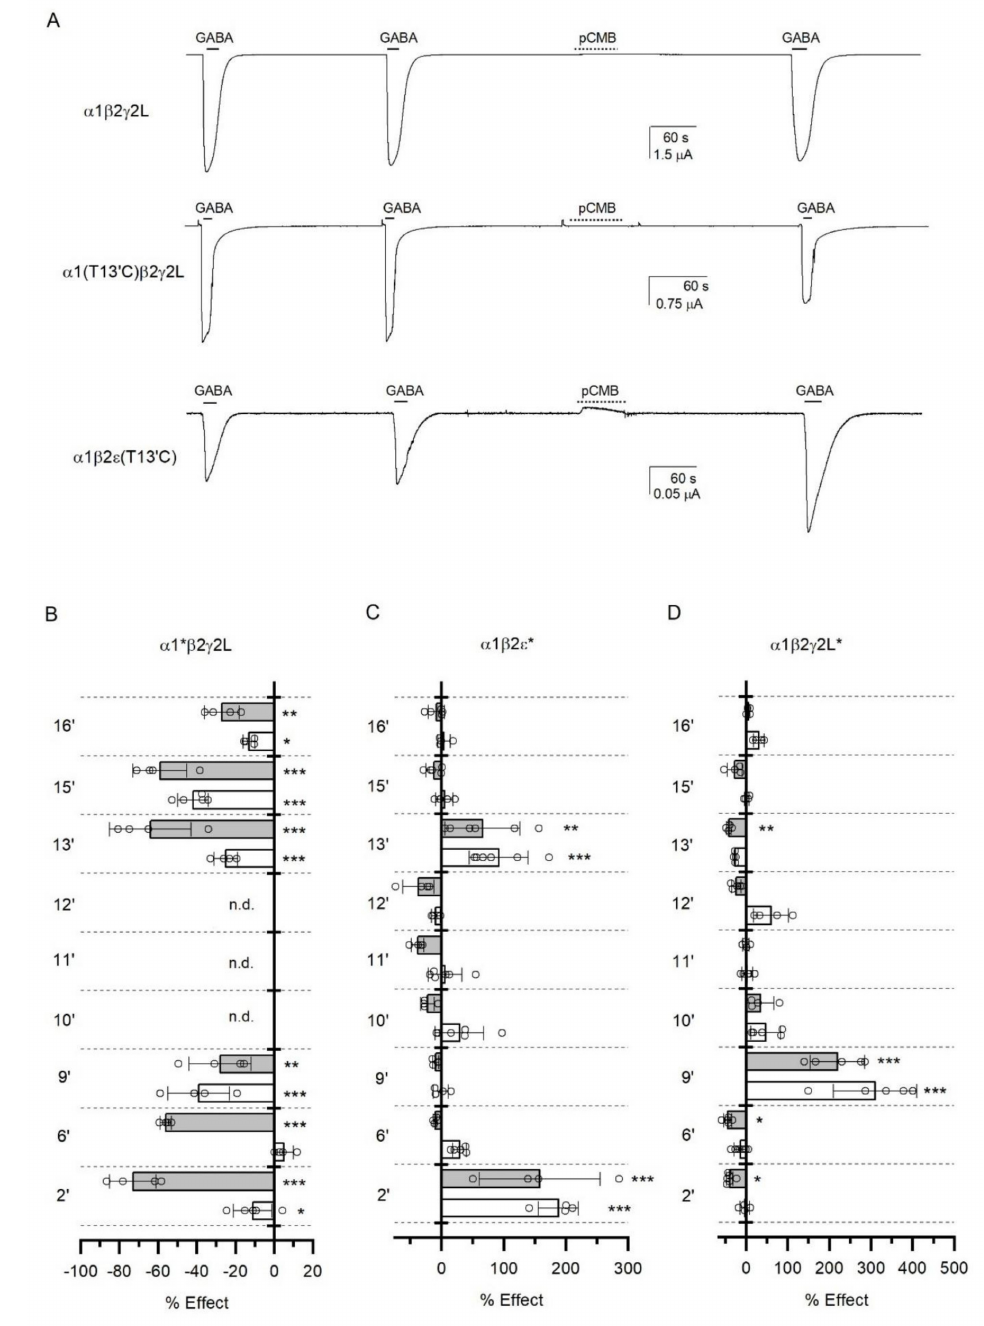
Figure 5. Accessibility of residues in TM2 in α 1, ε , and γ 2L subunits. ( A ) Sample traces showing the lack of effect of pCMB on response to GABA in the α 1 β 2 γ 2L receptor (top trace), the inhibitory effect of pCMB on response to GABA in the α 1(T13’C) β 2 γ 2L receptor (middle trace), and potentiating effect of pCMB on response to GABA in the α 1 β 2 ε (T13’C) receptor (bottom trace). In each trace, the concentration of pCMB was 100 µ M and the concentration of GABA was 1 mM. ( B ) Summary of effects of pCMB on α 1* β 2 γ 2L receptor ( α 1 β 2 γ 2L containing the TM2 mutations in the α 1 subunit) function. ( C ) Summary of effects of pCMB on α 1 β 2 ε * receptor function. ( D ) Summary of effects of pCMB on α 1 β 2 γ 2L* receptor function. In ( B – D ), the graphs show modulation of responses to saturating GABA upon exposure to pCMB alone (white) or pCMB + saturating GABA (grey). n.d., not done. Statistical tests were conducted using pairwise comparison of means with Dunnett’s correction. *, p < 0.05; **, p < 0.01; ***, p <